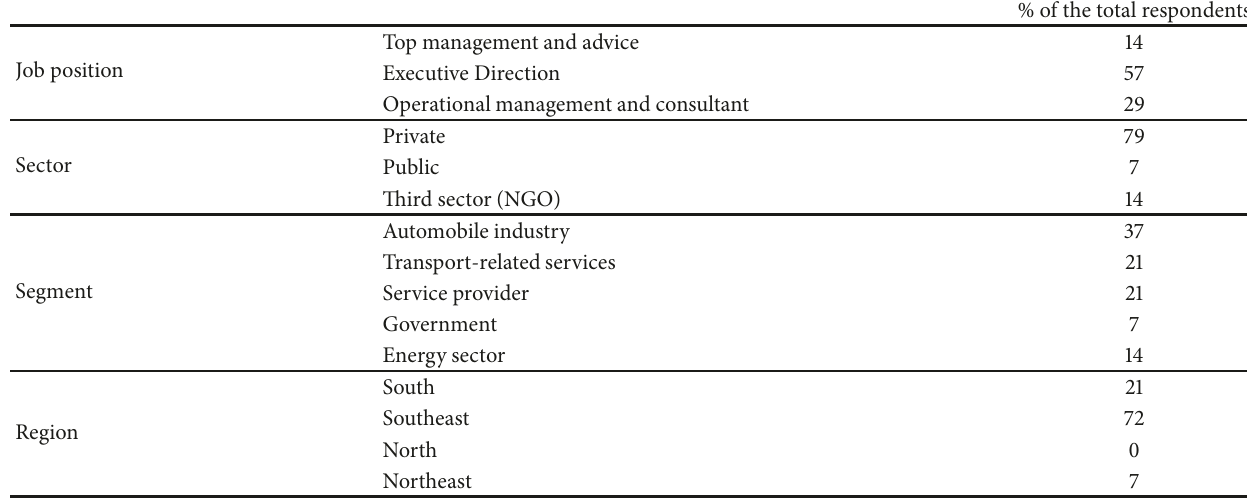
Table 2: Survey characterization.